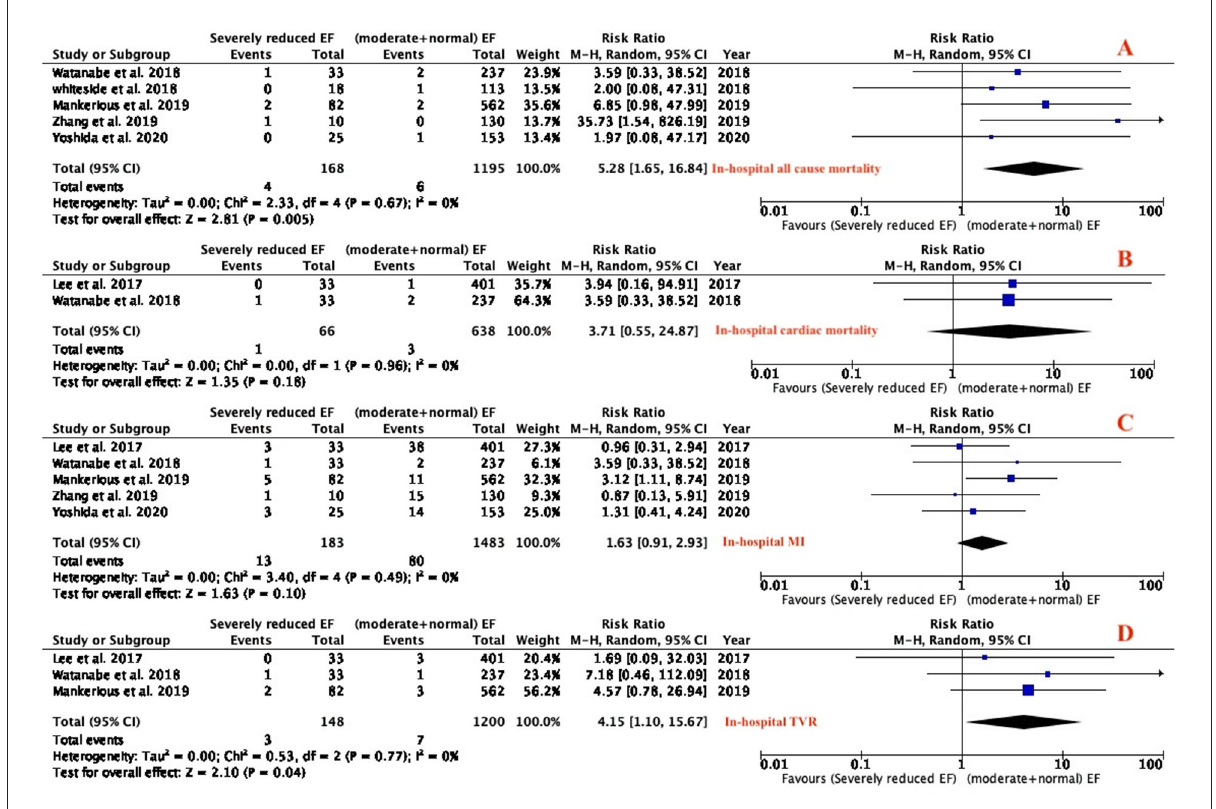
FIGURE2 Forest plot of in-hospital outcomes (all-cause mortality, cardiac mortality, MI, TVR). (MI, myocardial infarction; TVR, target vessel